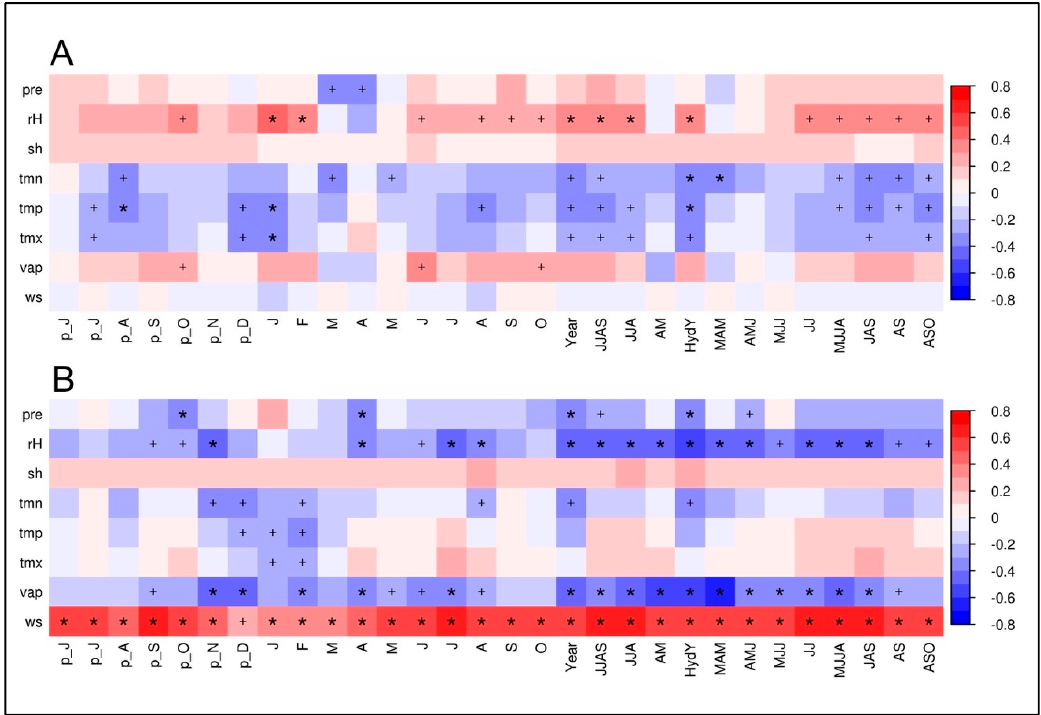
Figure 6. Climate–proxy relationships between δ 13 C TRC of juniper trees ( A ) and spruce trees ( B ) against different monthly and seasonal means of climate parameters (pre, precipitation; rH, relative humidity; sh, sunshine hours; tmn, minimum temperature; tmp, mean temperature; tmx, maximum temperature; vap, vapor pressure deficit; ws, wind speed) from the Qamdo climate station for the period 1954–2007 (n = 54). “p” shows relationships to the previous years’ monthly means. Red/blue color indicates a positive/negative correlation coefficient (r). The respective level of significance is indicated by a plus sign (p < 0.05) or an asterisk (p <